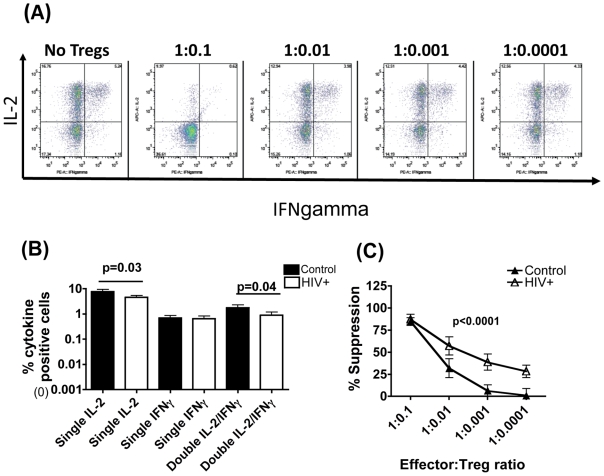
Treg cells from HIV+ subjects are potent suppressors of effector cell IFN-γ expression.20×104 effector T cells were stimulated with 2∶1 CD3/28 bead∶effector T cell ratio in the presence or absence of varying numbers of Treg cells. 5µg/ml final brefeldin A was added 2 hours after addition of stimulus and the cultures maintained for 16 hours, before washing, permeabilisation and staining for IFN-γ and IL-2. (A) Representative FACS plots show frequency of single and double IL-2 and IFN-γ+ cells in cultures with and without Treg cells. Paired t-test for differences between patients and controls in individual cytokines is shown. (B) Comparison of the frequency of single and double IL-2 and IFN-γ positive effector cells in chronic HIV+ patients (white bars, N = 18) and healthy controls (black bars, N = 13) following CD3/CD28 stimulation in the absence of Treg cells. (C) Comparison of the potency of suppression of single IFN-γ + effector cells in cultures from HIV+ (open triangle) versus control (closed triangle) subjects is shown. Unzeroed data points are plotted. For Fig 2(C), the Friedman test was used to determine overall mean differences between control (N = 13) and HIV+ (N = 13) subjects using balanced data points across all effector: target cell ratios and 2-sided p-value (p<0.0001) reported. The Mann-Whitney test was then used to compare differences between the patient and control groups at individual E∶T ratios and highlighted the following significant differences: E∶T = 1∶0.01, p = 0.04; E∶T = 1∶0,001, p = 0.0244 and E∶T = 1∶0.0001, p = 0.0188.